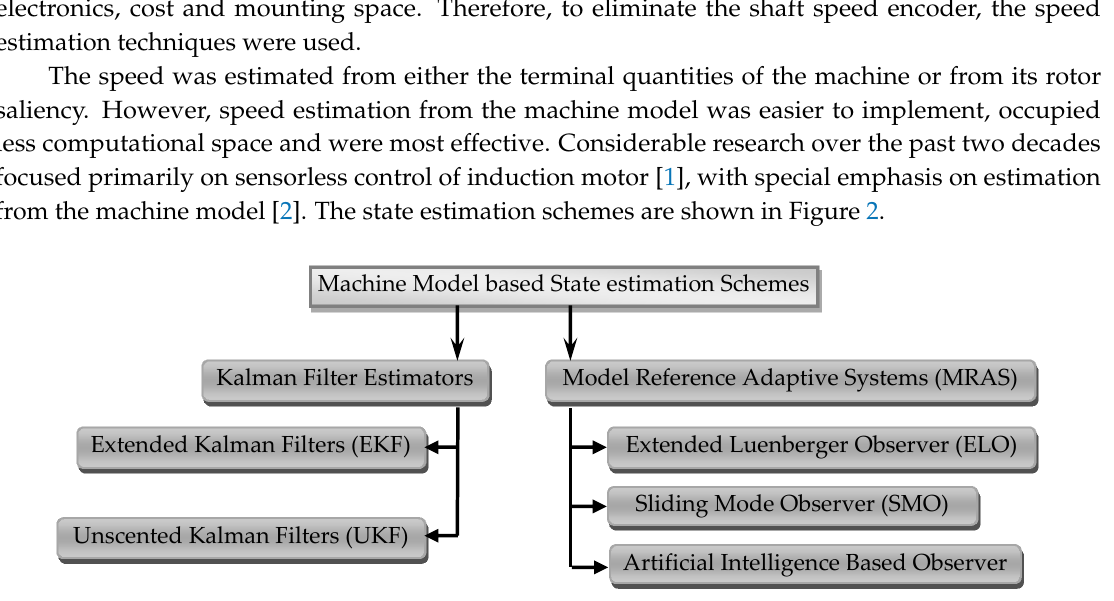
Figure 1. Indirect vector control principle.